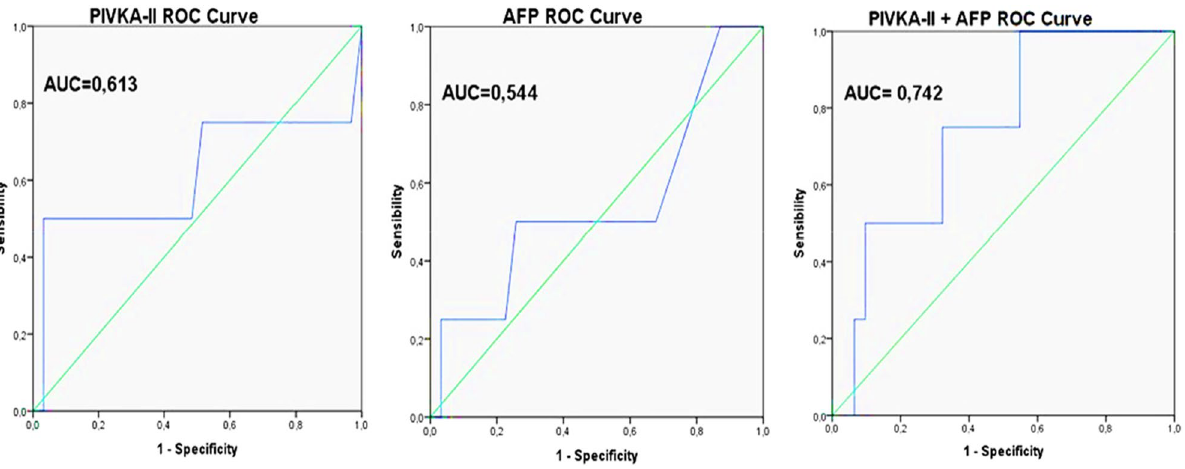
Figure 3. ROC curves of PIVKA-II, AFP and PIVKA-II +